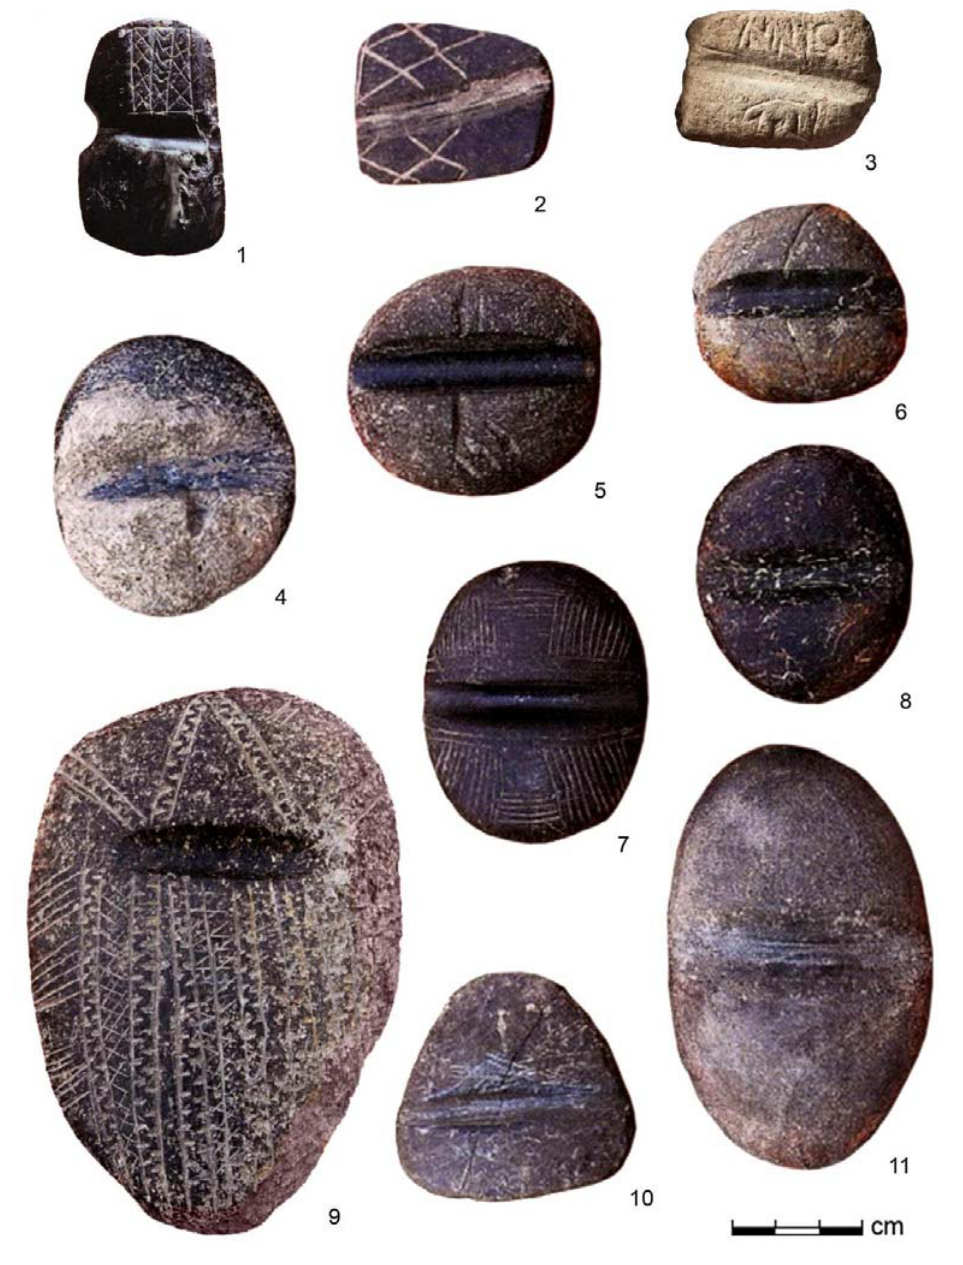
Figure 6. Grooved stones from “The Golden Triangle” (Upper Mesopotamia). 1: Cafer Höyük (Cauvin et al . 2011: 39, fig. 32); 2: Körtik Tepe (Özkaya & Coşkun 2011: 124, fig. 26); 3: Göbekli Tepe (Dietrich et al . 2014: 16, fig. 13; Photo: N. Becker, DAI); 4-11: Körtik Tepe (Özkaya & Coşkun 2011: 124, fig. 26, 27). 1, 3: without